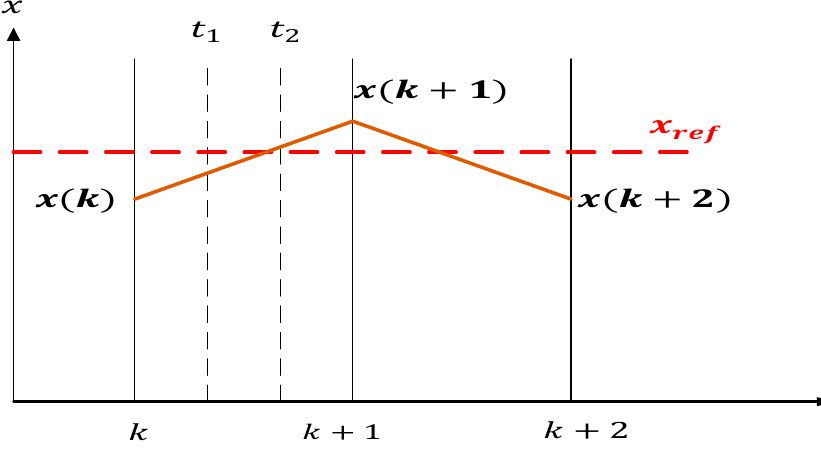
Figure 4. Time sequence for the model predictive control for digital implementation.